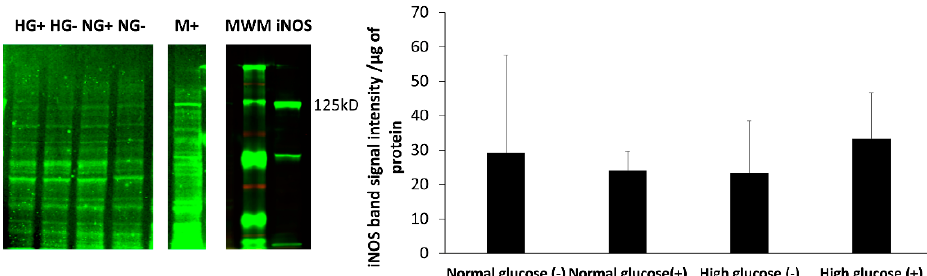
Figure 5. Detection of iNOS expression by western blot analysis of HDFa cultured in normal (NG) and high glucose (HG) conditions with (+) and without ( − ) stimulation. Predicted band size for iNOS 131 kD and observed band size 125kD with iNOS and RAW 264.7 (M+) as positive controls. MWM—Molecular weight marker.